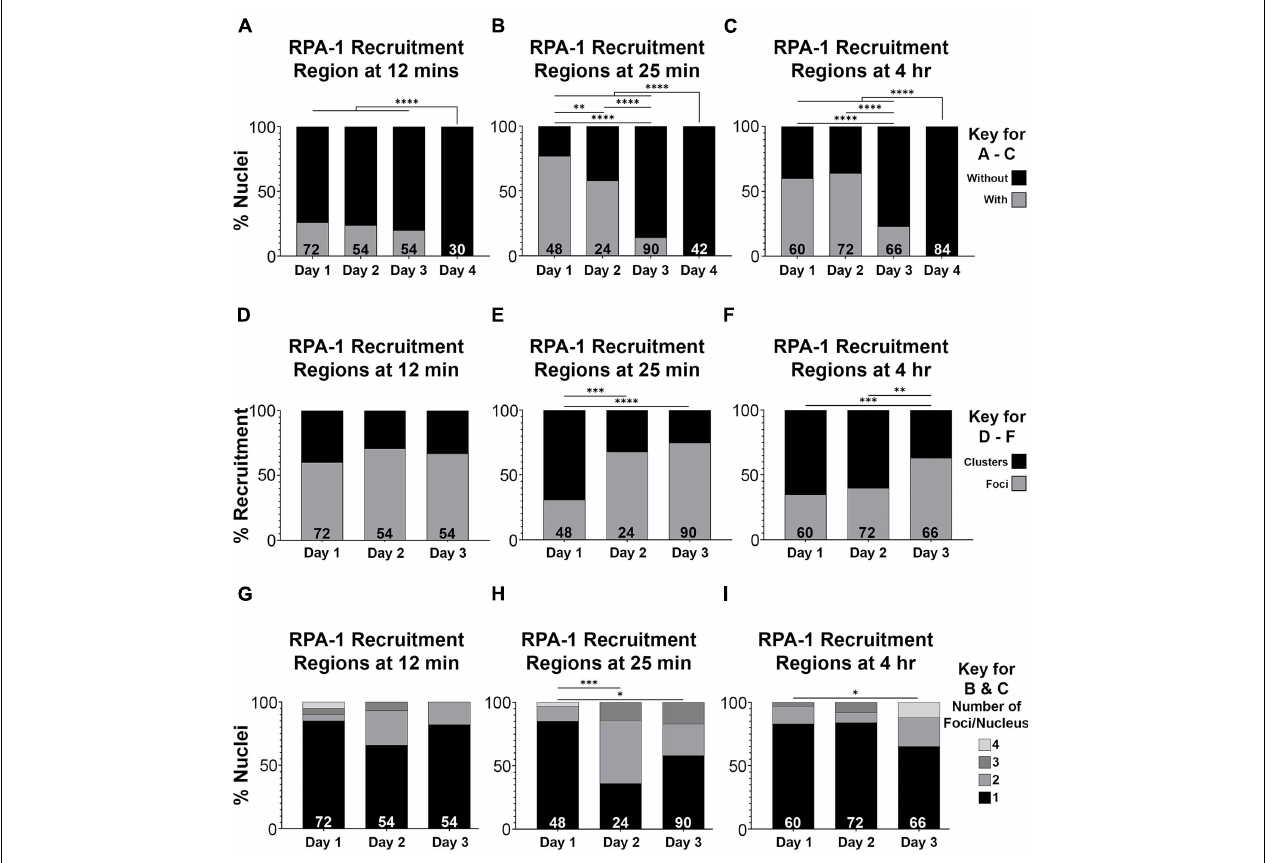
FIGURE 5 | RPA-1 dynamics complex DNA damage attenuates with age. (A–C) Percent of mid-pachytene nuclei with RPA-1 recruitment regions out of total number of nuclei 12 min (A) , 25 min (B) and 4 h (C) after microirradiation, in worms at 1, 2, 3, and 4 days post-L4. (D–F) Percent RPA-1 recruitment regions appearing as individual foci or as clustered foci per nucleus at 12 min (D) , 25 min (E) and 4 h (F) after microirradiation, in worms at 1, 2, and 3 days post-L4. (G–I) Percent of nuclei with the indicated number of RPA-1 recruitment regions per nucleus 12 min (A) , 25 min (B) and 4 h (C) after microirradiation, in worms at 1, 2, and 3 days post L4. Statistical significance was determined using the Fisher’s Exact test and p -values are indicated as follows: ns ≥ 0.1234, 0.0332–0.1233 = ∗ 0.0021–0.0331 = ∗∗ 0.0002–0.0020 = ∗∗∗ , ≤ 0.0001 = ∗∗∗∗ . N values as indicated for each